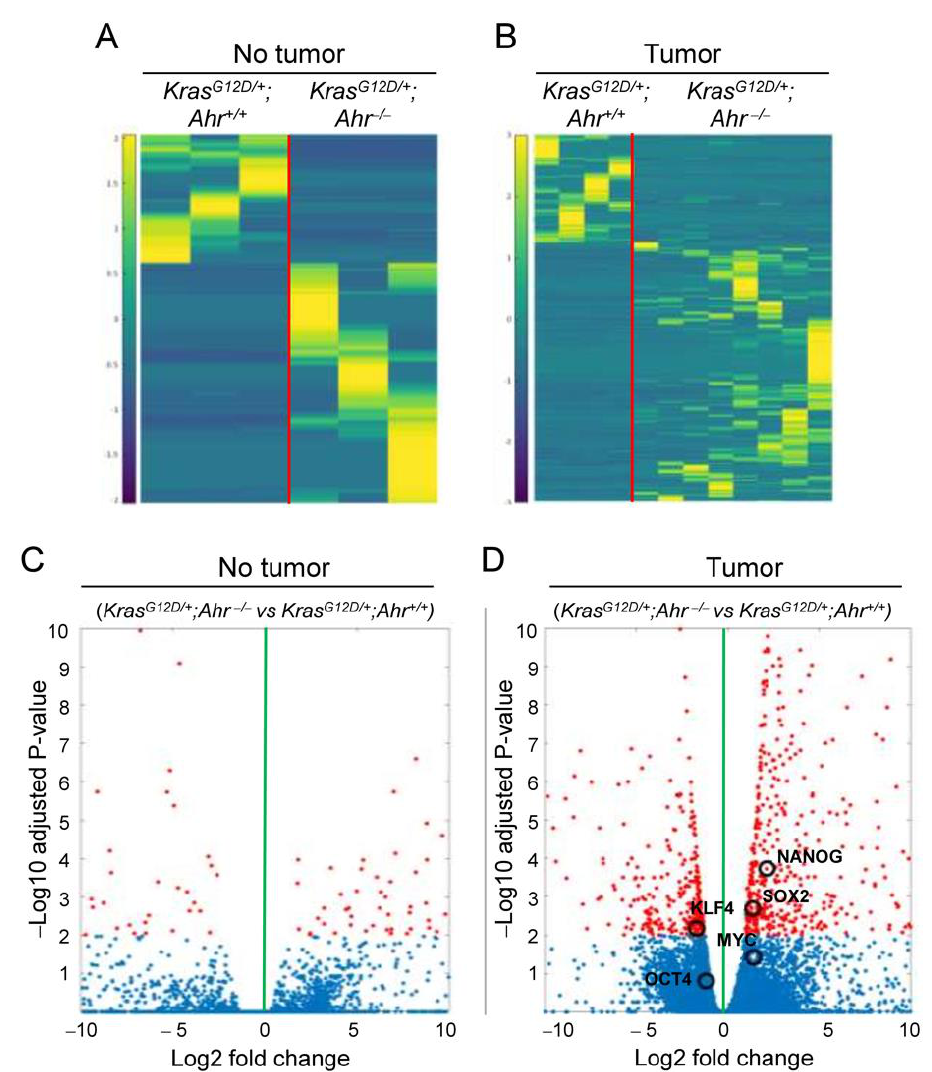
Figure 6. The Ahr genotype modulates gene expression patterns in normal and K-RasG12D-expressing NSCLC tumors. Non-tumor and tumor tissues were recovered from K-Ras G12D/+ ; Ahr +/+ and K-Ras G12D/+ ; Ahr − / − lungs and analyzed for global gene expression by RNAseq. ( A , B ) Heatmaps of differentially expressed genes (DEG) in non-tumoral ( A ) and tumoral lung tissue ( B ) of K-Ras G12D/+ ; Ahr − / − mice as normalized by the expression levels present in K-Ras G12D/+ ; Ahr +/+ mice. ( C , D ) Volcano plots of non-tumoral ( C ) and tumoral lung tissue ( D ) DEGs of K-Ras G12D/+ ; Ahr − / − mice as normalized by their expression in K-Ras G12D/+ ; Ahr +/+ mice. Samples showing significant DEGs between K-Ras G12D/+ ; Ahr +/+ and K-Ras G12D/+ ; Ahr − / − genotypes (adjusted p -value < 0.01 and absolute Log 2 fold change > 1) are showed in red dots; non-DEGs are shown in blue dots. The expression of pluripotency genes Nanog ( p < 0.001), Sox2 ( p = 0.002), Klf4 ( p = 0.004), Oct4 ( p = 0.4) and c-Myc ( p = 0.12) are highlighted within open circles. N = 4 for each condition assayed.